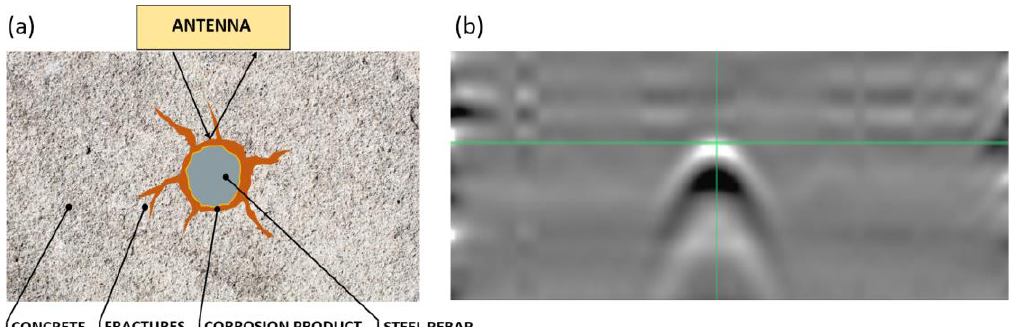
Figure 1. ( a ) GPR acquisition on corroded rebar in concrete; ( b ) radargram acquired along the concrete sample, the hyperbola corresponds to corroded rebar.